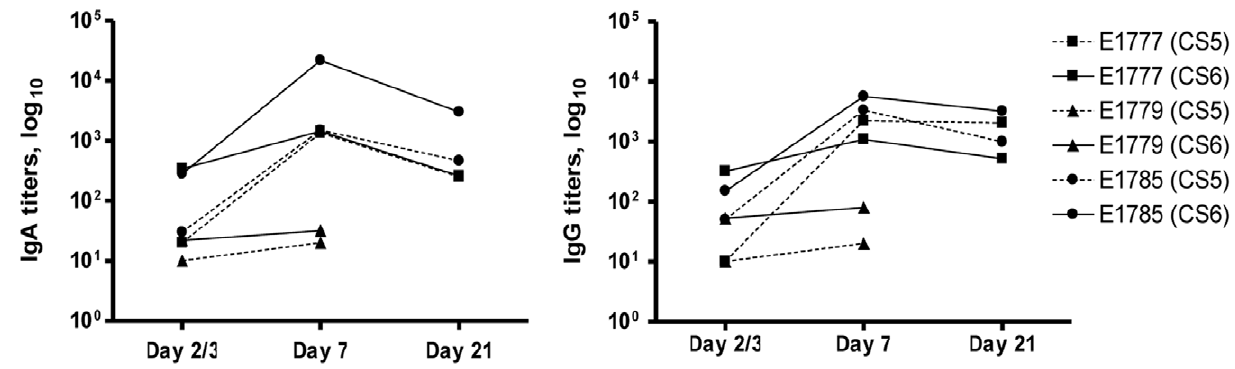
Figure 1. IgA and IgG serum antibody responses to CS5 and CS6 in individual patients. The responses to CS5 (broken lines) and CS6 (solid lines) were measured by ELISA in sera from patients infected with strains E1777, E1785 and E1779, on different days after hospitalization. Serum from the patient infected with strain E2265 was not available.